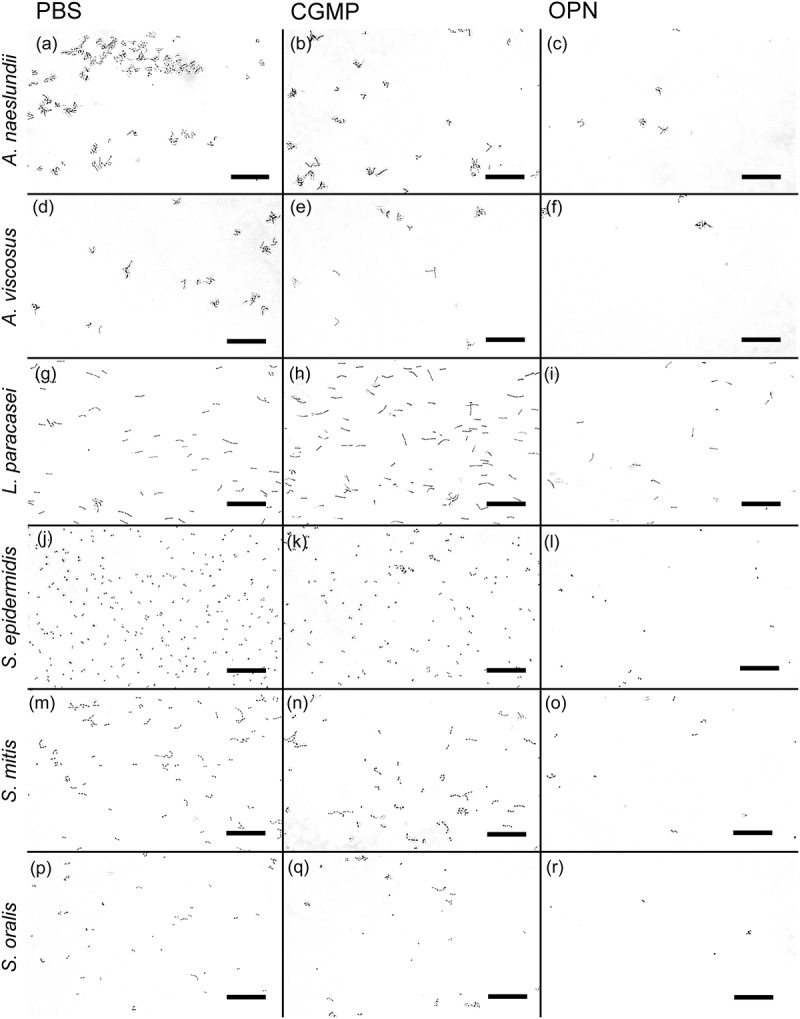
Representative bright field images of adhering bacteria. Adhesion was tested under flow (9.45 µL/h) in the presence of saliva and phosphate-buffered saline (PBS; left column), 460 µM of caseinoglycomacropeptide (CGMP; middle column), or 460 µM of osteopontin (OPN; right column). Considerably fewer cells of Actinomyces naeslundii (a–c), Actinomyces viscosus (d–f), Lactobacillus paracasei subsp. paracasei (g–i), Staphylococcus epidermidis (j–l), Streptococcus mitis (m–o), and Streptococcus oralis (p–r) adhered in the presence of OPN compared to CGMP and control treatment with PBS. In experiments with S. epidermidis, saliva was omitted. Bars = 20 µm.